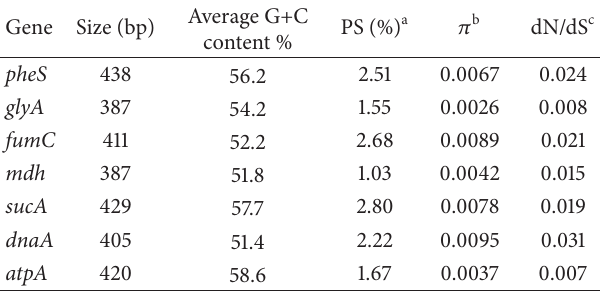
Table 3: Characteristics of each housekeeping gene.